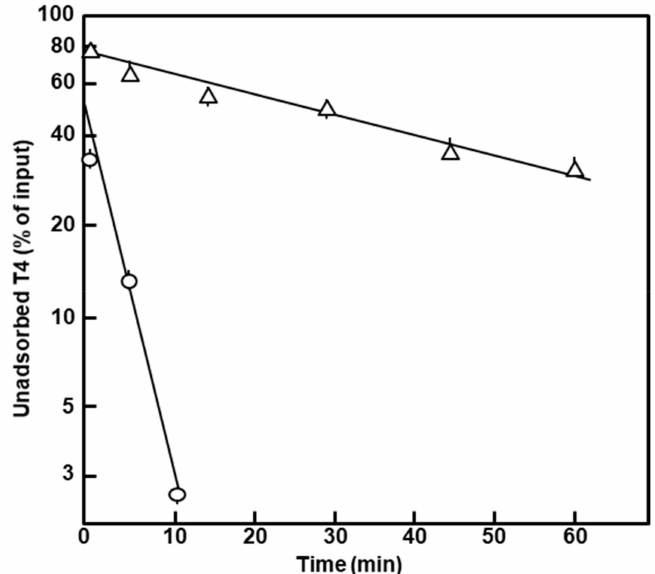
Figure 5. Kinetics of T4 phage adsorption to intact cells. T4D phage was added to the polylysogen ( ∆ ) and nonlysogen (o) exponential phase cultures at an input m.o.i. (multiplicity of infection)